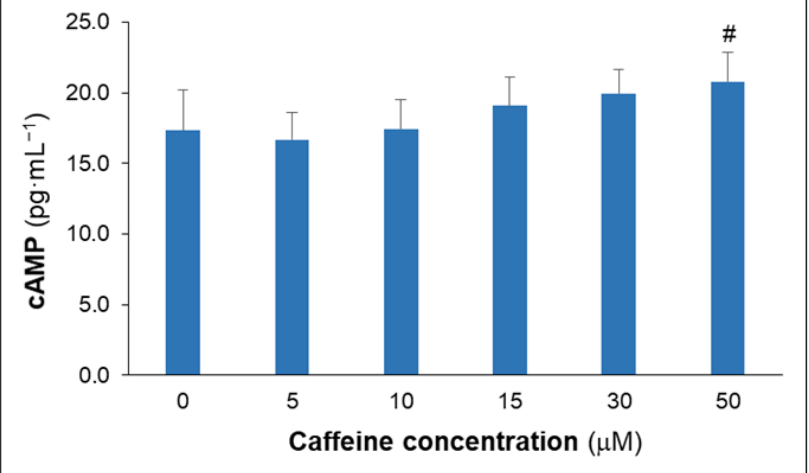
Figure 1. Effects of caffeine and LPS-stimulation on culture cAMP concentrations. Values are expressed as means ± SD. # indicates significant differences vs. control. cAMP: Adenosine-3 ′ , 5′ -cyclic monophosphate.